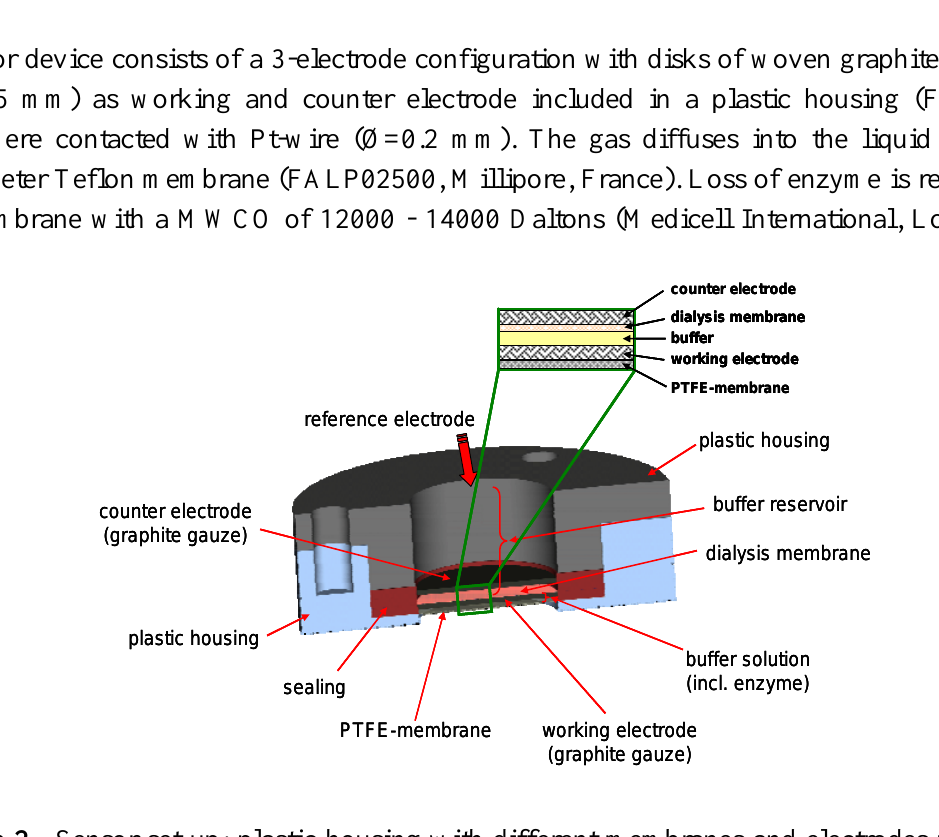
Figure 2. Sensor set-up: plastic housing with different membranes and electrodes for the detection of the gaseous analyte formaldehyde.